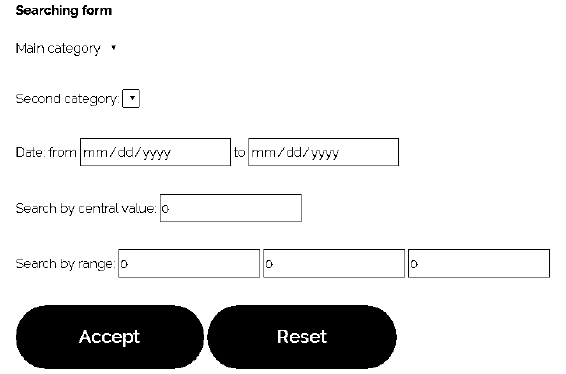
Figure 3. Available input parameters for the search